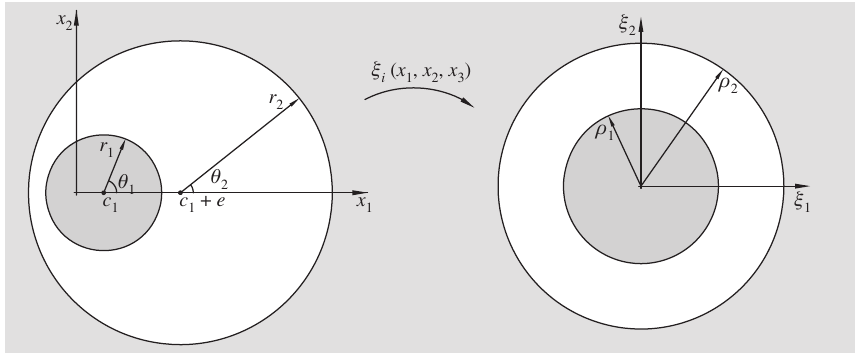
Figure 2: Top view of the three-dimensional mapping given by Eq.